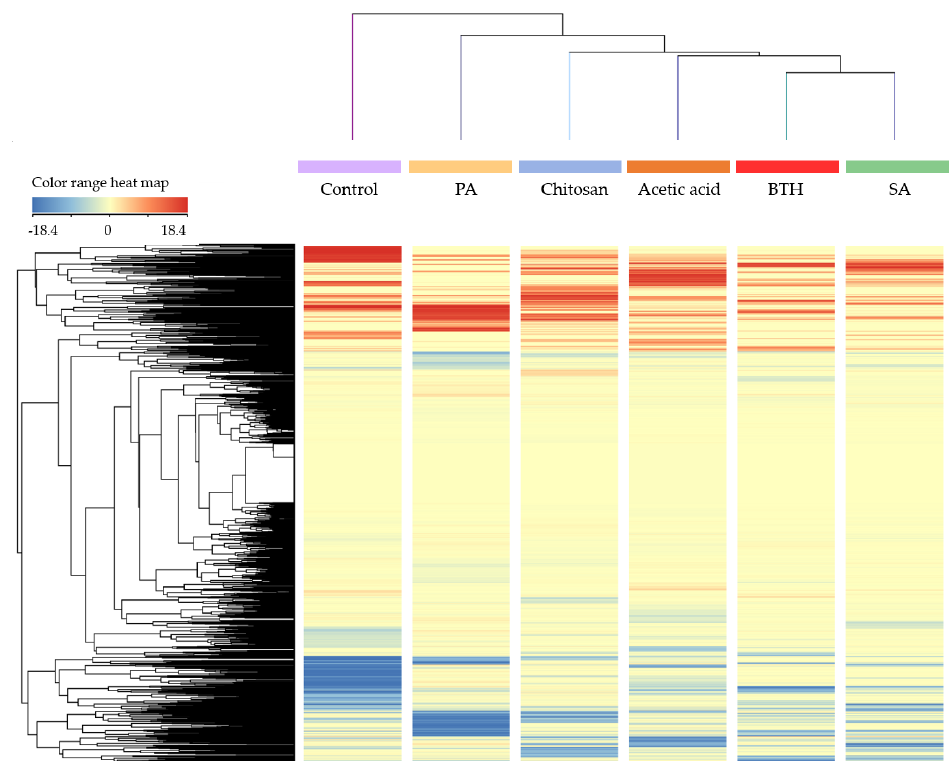
Figure 1. Unsupervised hierarchical cluster analysis of the whole metabolomics profiles in tomato leaves following the different elicitor treatments. Metabolites were obtained through UHPLC- ESI/QTOF-MS untargeted analysis, and their intensities were used to create the heat map in the figure, based on fold-change values (color range heat map is provided on top left). The cluster on top refers to similarities across treatments, whereas the cluster on left reports compound clusters (both according to Euclidean distance and Ward’s linkage rule). Afterwards, a supervised approach based on orthogonal projection to latent struc- tures discriminant analysis (OPLS-DA) allowed us to separate the samples in the score plot space according to the treatments. This supervised modeling allowed for confirming the presence of distinct metabolic profiles in treated leaves compared to the control (Fig- ure 2) and in agreement with HCA. In fact, samples corresponding to differently treated plants were distributed along the first latent vector, while the second component clearly separated the control samples from the treated. These multivariate modelings also re- vealed that chitosan, BTH, and SA had closer metabolic profiles, while PAs showed the most distinguished profile. The variable importance in projection (VIP) analysis following OPLS-DA identified 100 metabolites with the highest discriminant potential (VIP score >1.25). The most represented biochemical classes of compounds belonged to hormones, phenylpropanoids, and nitrogen-containing secondary metabolites (Supplementary Table S2).